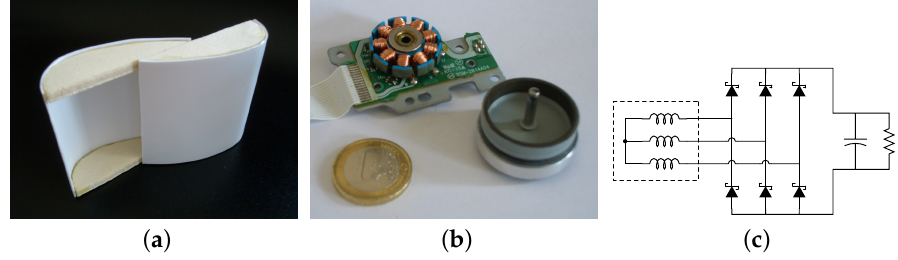
Figure 1. The small vertical-axis wind turbine used for the comparison and the inrunner brushless generator coupled with it. ( a ) Plastic Savonius turbine; ( b ) Disassembled motor; ( c ) Rectifier circuit.